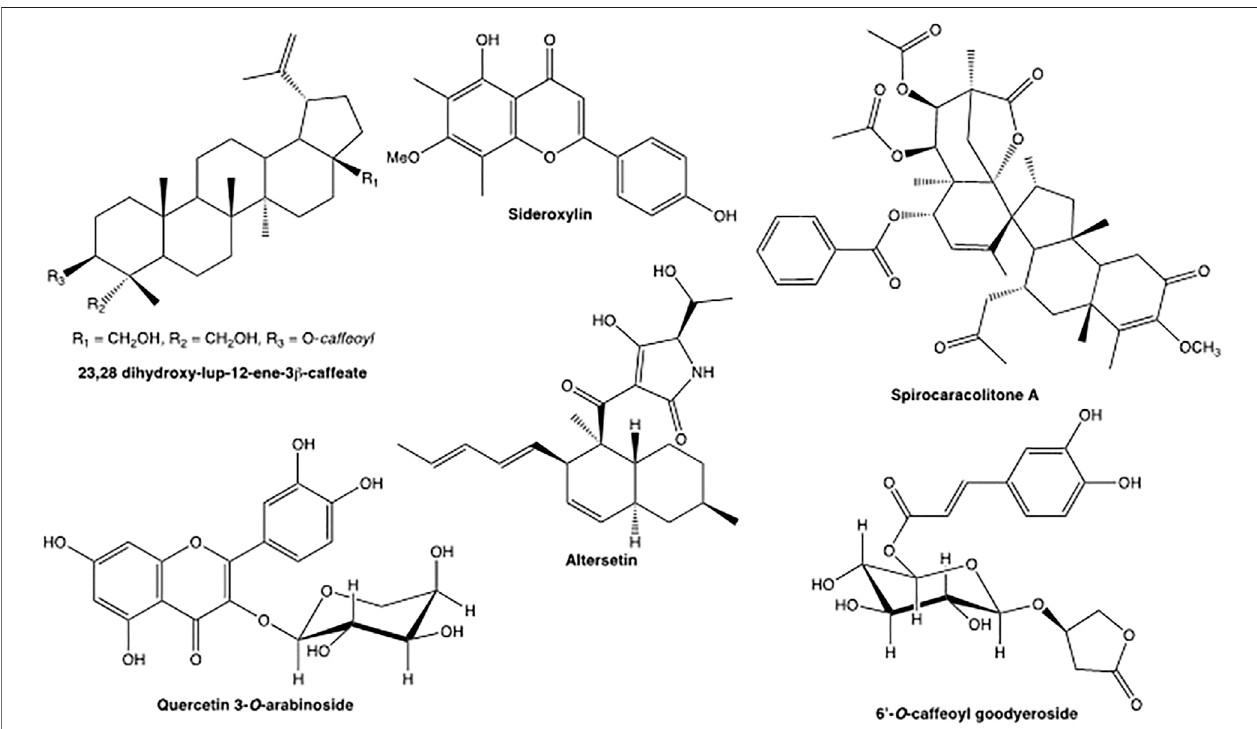
FIGURE 3 | New bioactive compounds from plants and